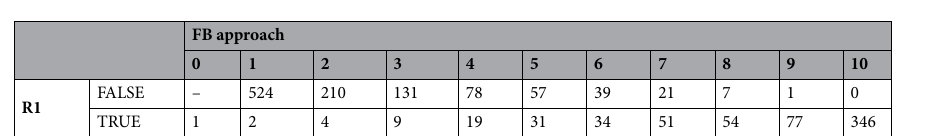
Figure 7. Left: distribution of gene-wise dispersions estimated in the real and artificial data sets. These dispersions reflect the biological variance of the nine samples. Right: distribution of gene-wise dispersions between true replicates R1 and R2, as well as between all FB, all CB and all MO samples. These distributions reflect the variance between each set of replicates.